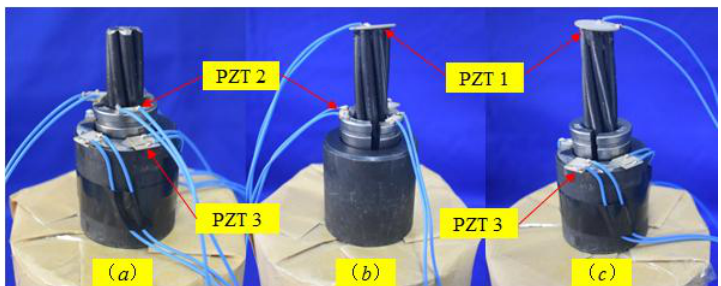
Figure 5. PZT locations for three contact surface monitoring methods of anchorage. (a): contact surface between the wedge and barrel; (b): contact surface between the steel strand and wedge; (c): contact surface between the steel strand and barrel.